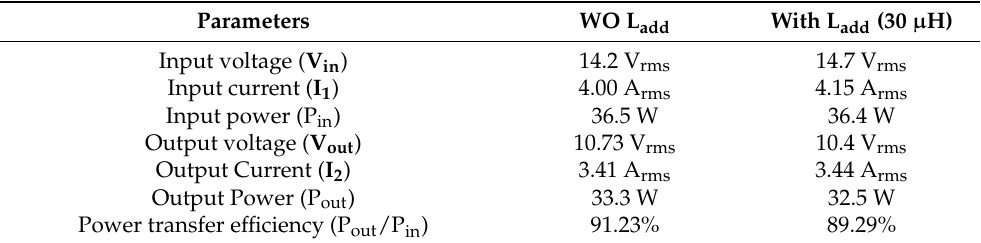
Table 13. Experimental results of a 30 W class WPT system according to the presence of L add (30 µ H ).